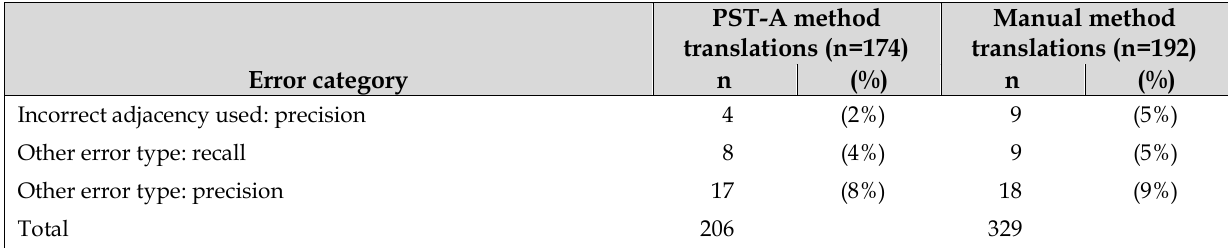
Table 3 Number and percent of unique errors in search string translations